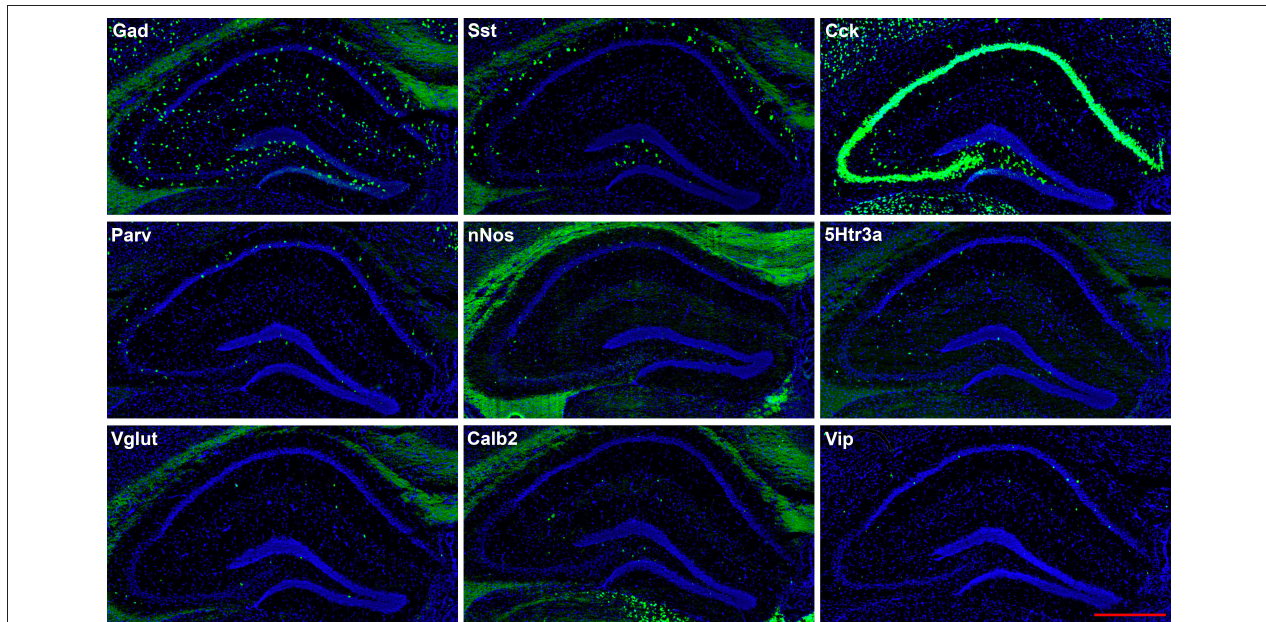
FIGURE 2 | Representative low-magnification photomicrographs showing expression of nine interneuron types in sections 1.8mm behind the bregma. This is the level at which the interneurons were counted. See Figure 1 for hippocampal layer and region delineations. White matter tracts show some autofluorescence (green) in some panels. In this and subsequent figures, Gad and Vglut stand for Gad-1 and Vglut3, respectively. The bar equals 500 µ m for all panels.